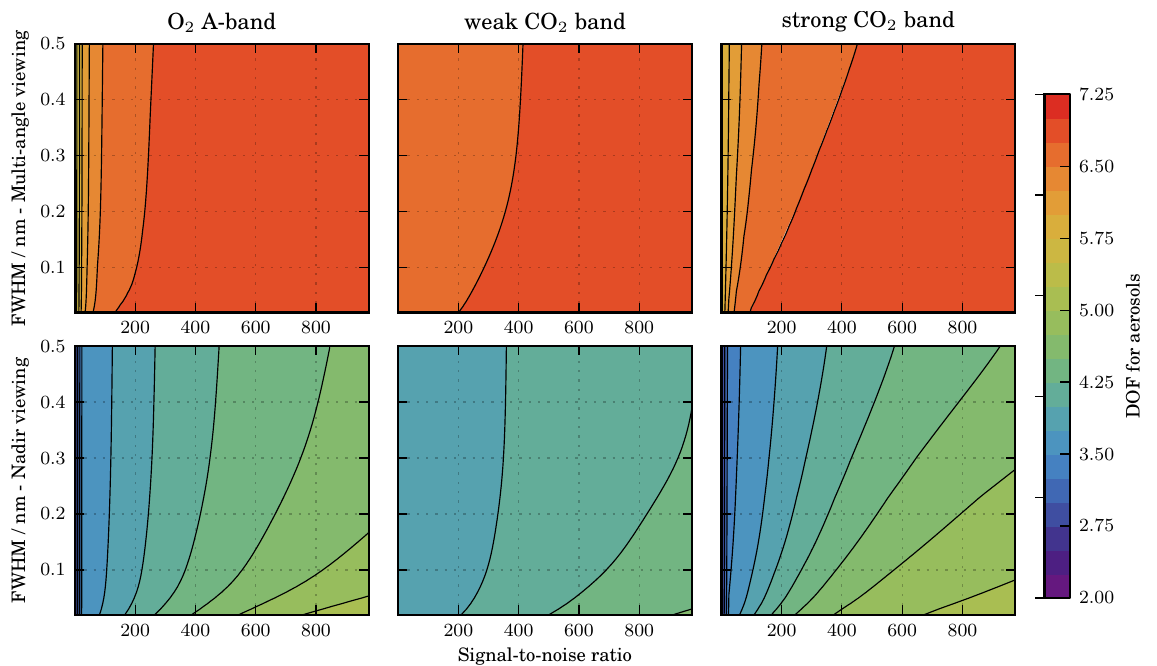
Fig. 8. Large solar zenith angle case ( ≈ 65 ◦ ). Otherwise like Fig. 7. Note that the theoretically maximum of DOF in our setup is 7, i.e., the total amount of aerosol state vector